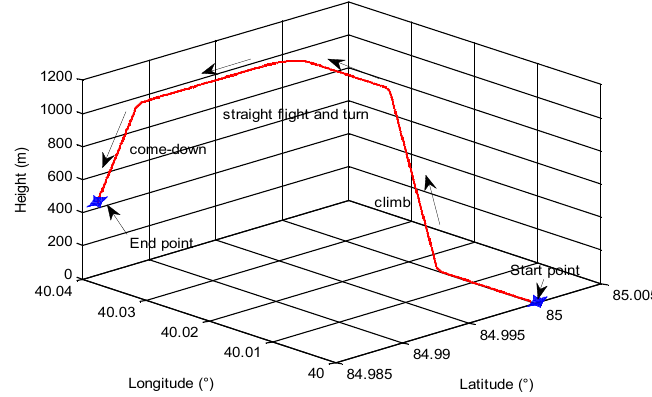
Figure 8. The flight trajectory for the dynamic test in polar areas.